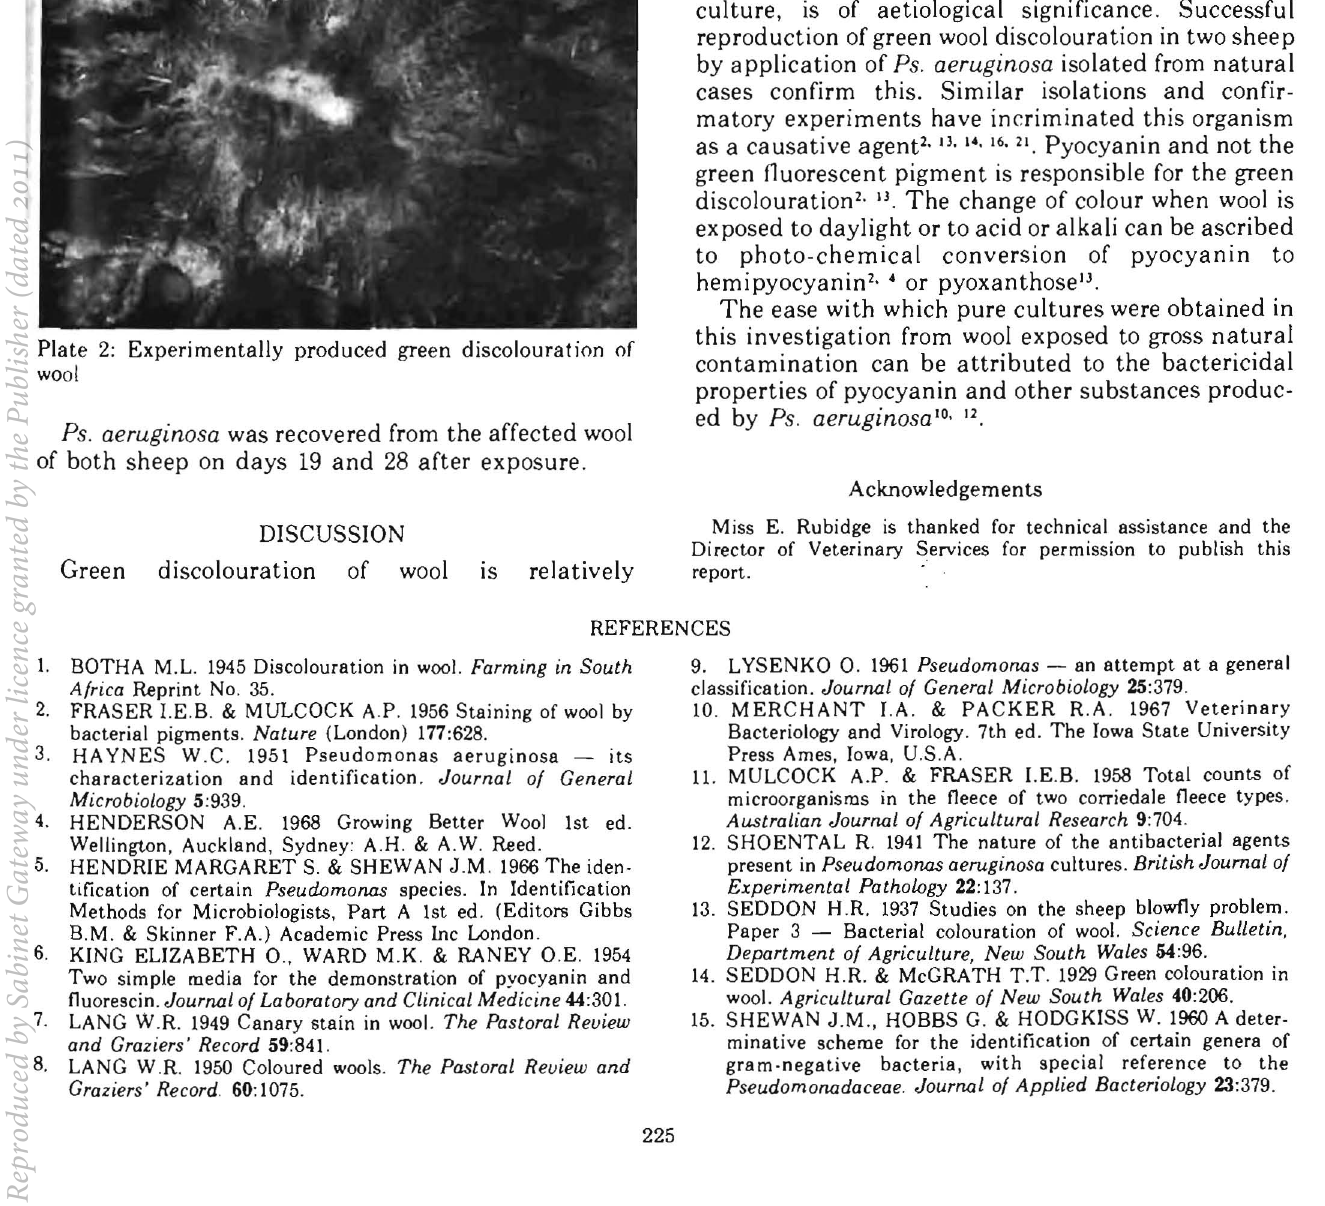
Plate 2: Experimentally produced green discolouration of wool Ps. aeruginosa was recovered from the affected